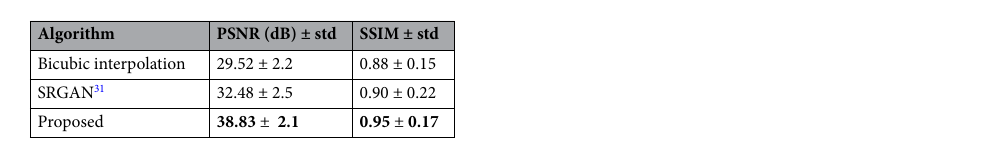
Table 6. Results on brain MRI images. Significant values are in [bold].